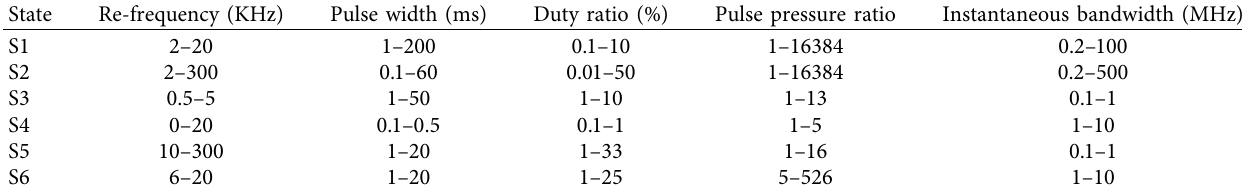
Table 1: Radar operating parameter ranges.